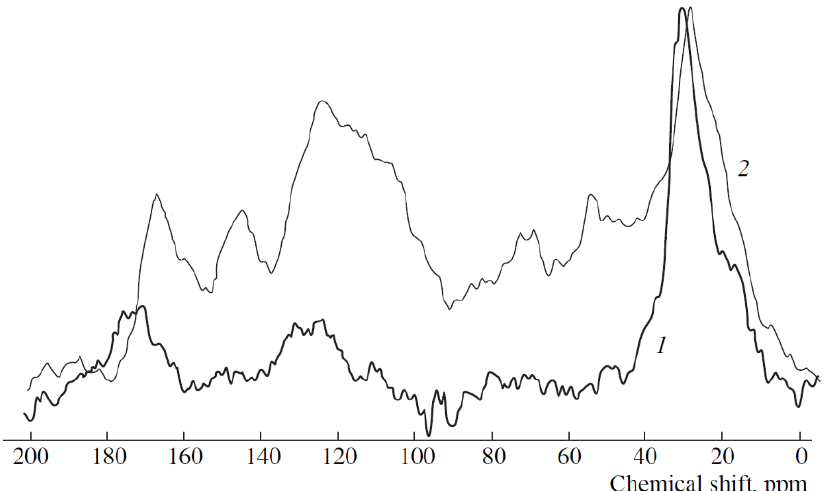
Figure 2. CPMAS 13 C NMR spectra of HAs from mature (1) and arable (2) Retisols.